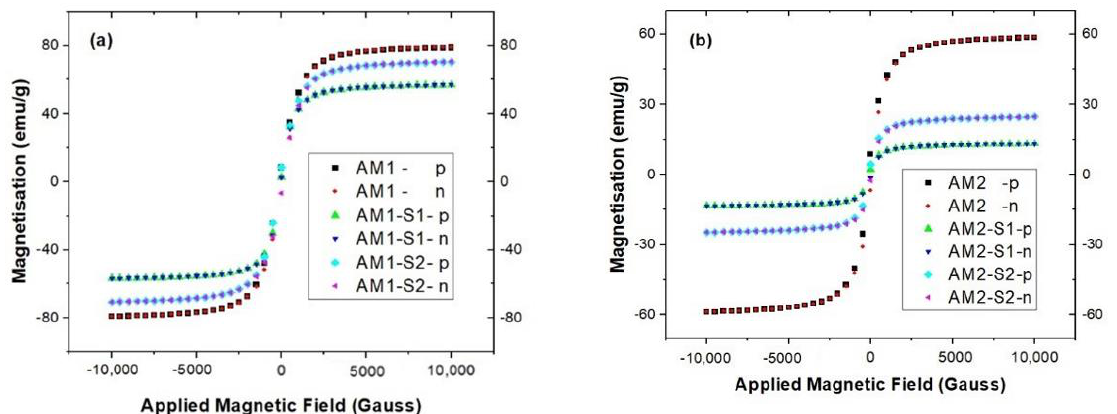
Figure 5. Magnetic hysteresis loops of the in ( a ) AM1(-/S1/S2) and ( b ) AM2(-/S1/S2) samples .